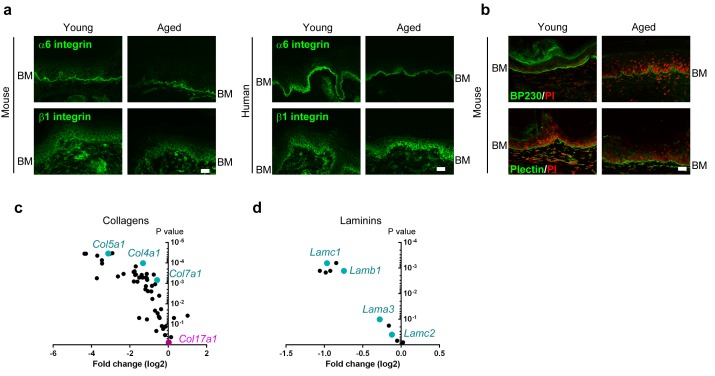
Expression of BMZ and extracellular matrix proteins in the IFE skin of young and aged WT mice and healthy individuals.(a) Staining of integrin α6 and β1 in young/aged mouse and human IFE samples (representative images from five mice). Scale bar: 20 μm. (b) Labeling of BP230 and plectin in the mice IFE (representative images from five mice). Scale bar: 20 μm. (c, d) Expression data from the microarray (four mice from young and aged groups, respectively) of genes encoding collagens (c) and laminins (d). The fold changes are based on the young group.